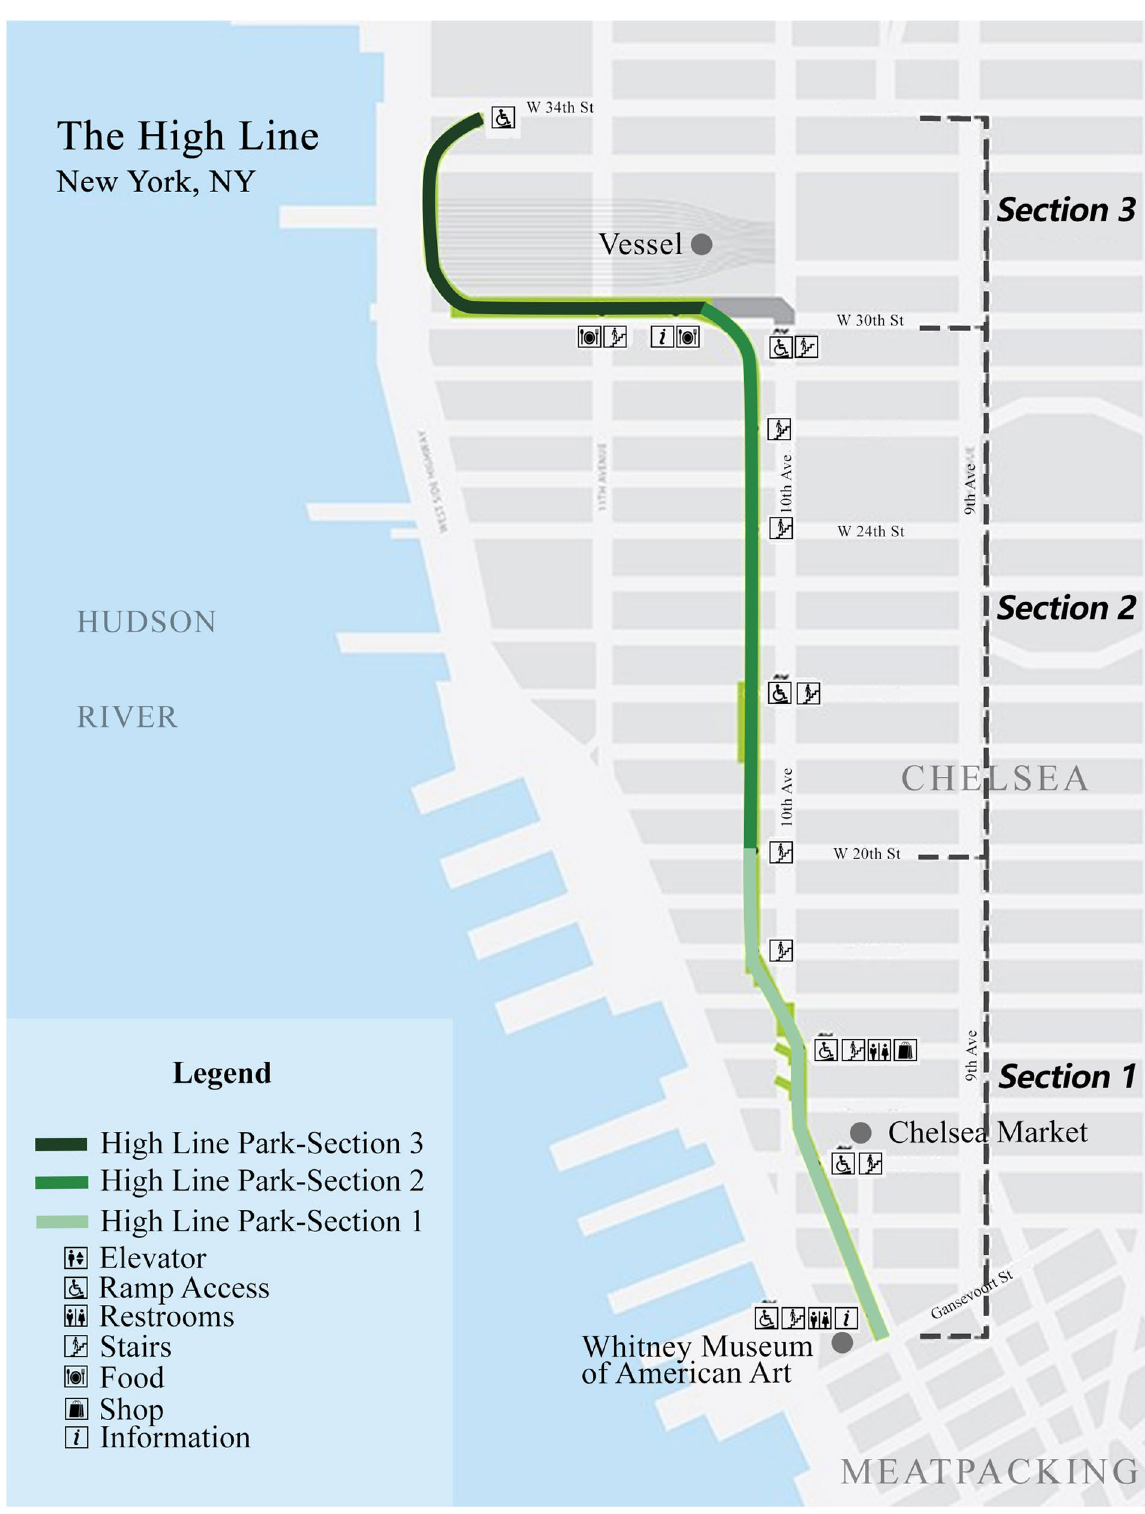
Fig. 1 Location of The High Line in Manhattan,